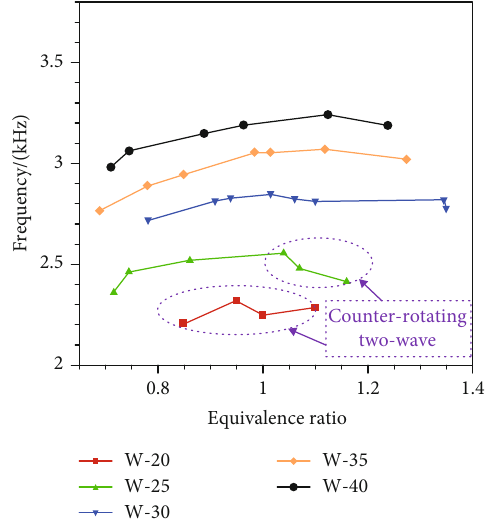
Figure 16: E ff ects of combustor width on propagation frequency.